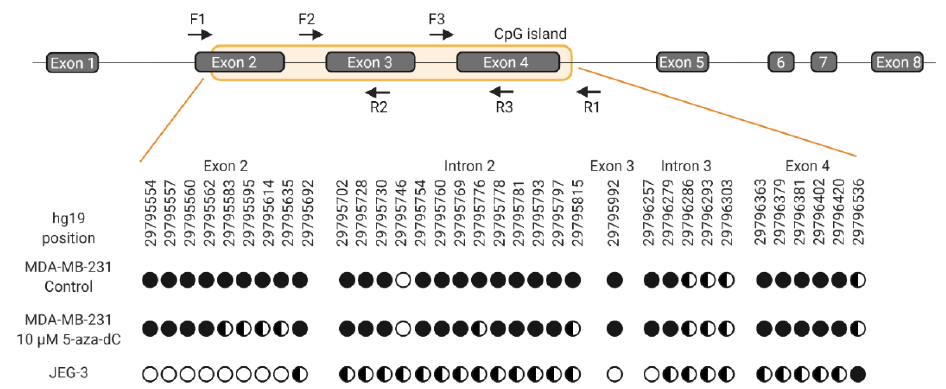
Figure 8. Schematic representation of the HLA-G gene and methylation status of selected CG sites. For bisulfite sequencing, three overlapping amplicons covering the CpG island were used. Forward and reverse primers indicated by arrows are matched in pairs F1R2, F2R3, and F3R1, respectively. HLA-G nomenclature follows NCBI annotation and prediction of CpG island is from USCS Genome Browser. Black circles indicate methylation, empty circles indicate no methylation and half-filled circles indicate partly methylation. Multiple CG dinucleotides in the CpG island could not be determined due to polymerase slippage in T rich areas. Therefore, an analysis of all CG sites within the CpG island was not possible.